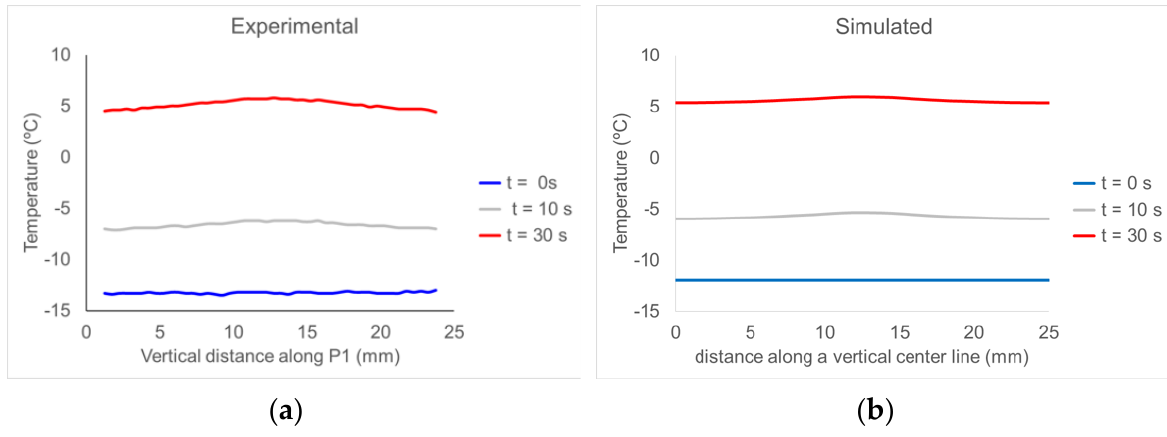
Figure 5. Temperature profile along P1 (Figure 2) on heated AA6061. Experimental ( a ) and simulated ( b ). P = 10.9 W, V = 0 m/s.